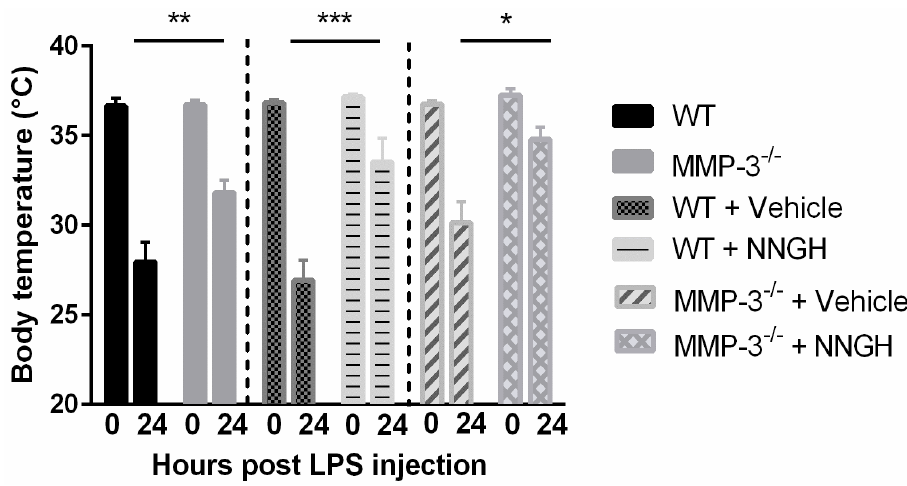
Figure 3. Influence of MMP-3 deficiency on body temperature during EIU, observed during independent experiments (indicated by dotted lines). At 24 h post LPS injection, body temperature clearly dropped in naive- and vehicle- (DMSO 5%) treated WT mice. MMP-3 deficiency resulted in a reduced sensitivity for LPS as shown by the significantly higher body temperature in MMP-3 − / − and N -Isobutyl- N -(4-methoxyphenylsulfonyl)-glycyl hydroxamic acid (NNGH)-injected mice, as compared to WT and vehicle-treated animals, respectively. Treatment of MMP-3 − / − mice with NNGH resulted in a more pronounced attenuation in the hypothermic response as compared to vehicle-treated MMP-3 − / − mice. Data are shown as mean ± SEM, n ≥ 5, * p ≤ 0.05, ** p ≤ 0.01, *** p ≤ 0.001.